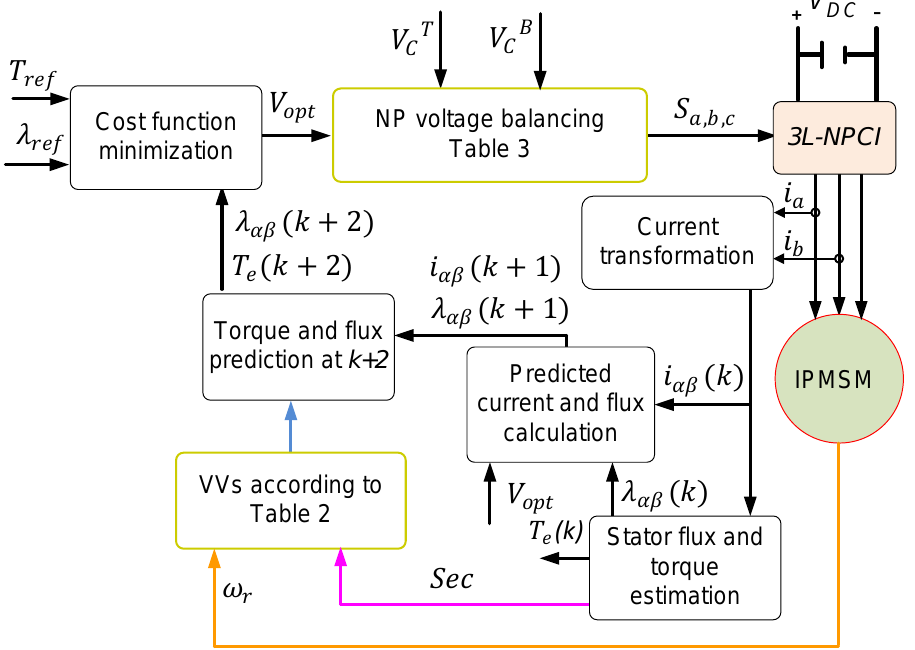
Figure 3. UFCS-PTC of PMSM fed by 3L-NPC inverter.